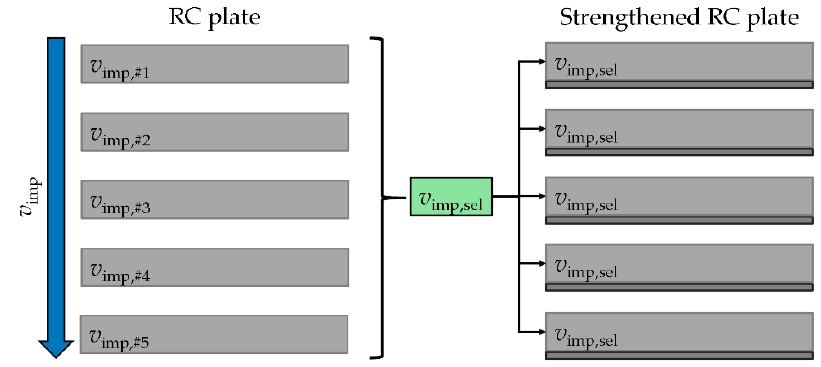
Figure 3. Schematic experimental schedule; Hering [17].